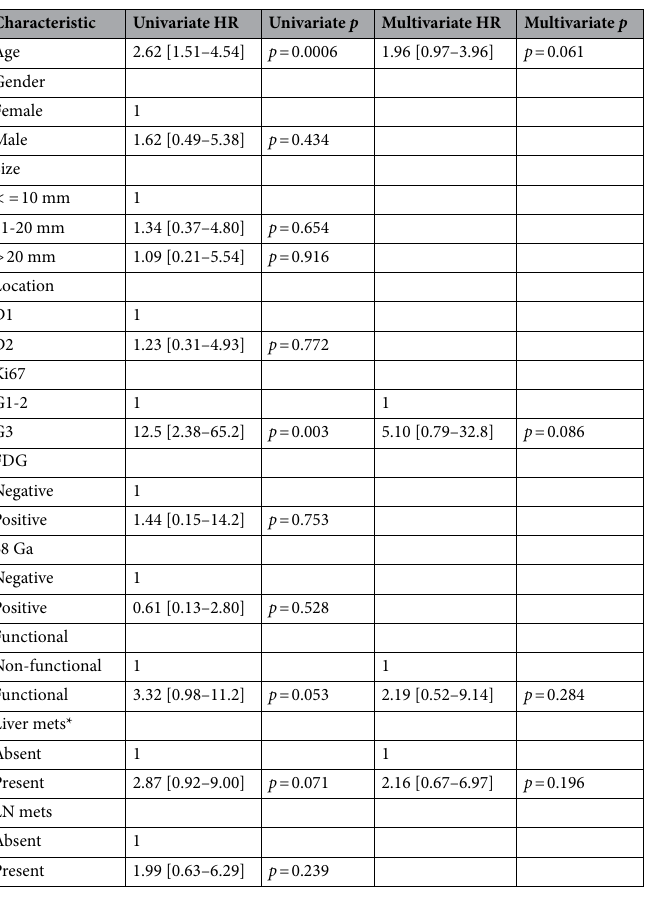
Table 2. Cox-hazards ratio for univariate and multi-variate analysis for OS for dNENs. *Co-linear with Ki67 so calculated in separate multivariate model. See supplementary